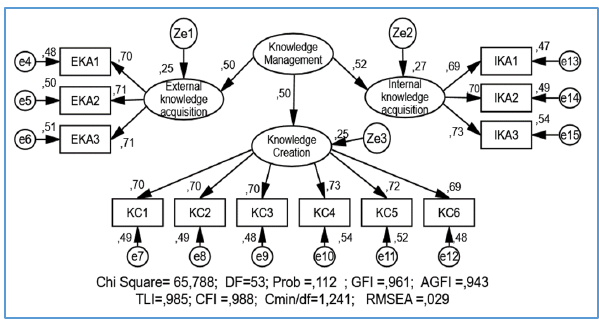
Fig. 3. Second Order of Knowledge Management